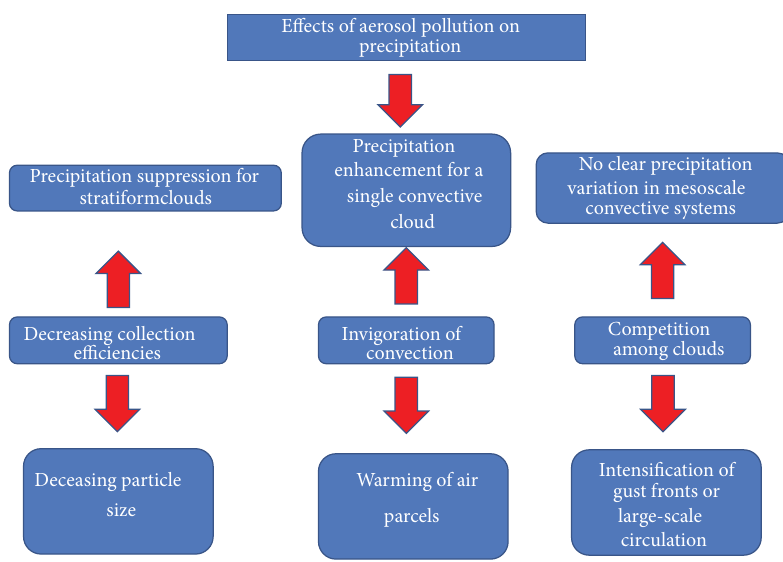
Figure 2: Schematic diagram illustrating differences in precipitation responses to aerosol perturbation among cloud types.